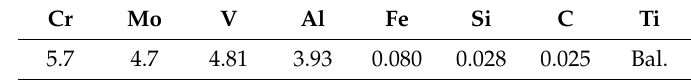
Table 1. Chemical composition of Ti-6554 alloy (mass fraction, %).